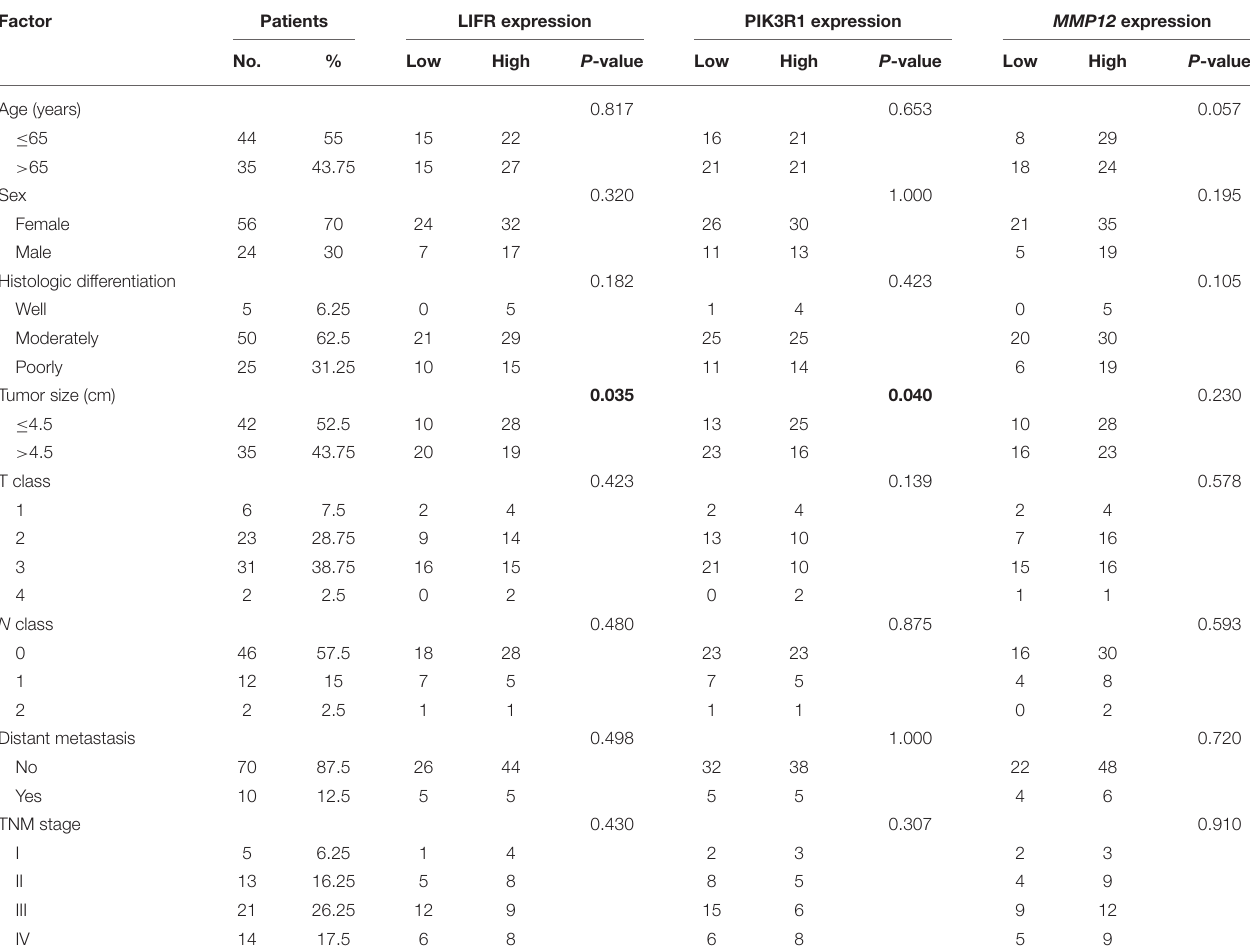
TABLE 2 | Relation between expression of LIFR, PIK3R1, and MMP12 proteins and clinical characteristics of GBC. Factor Patients LIFR expression PIK3R1 expression MMP12 expression